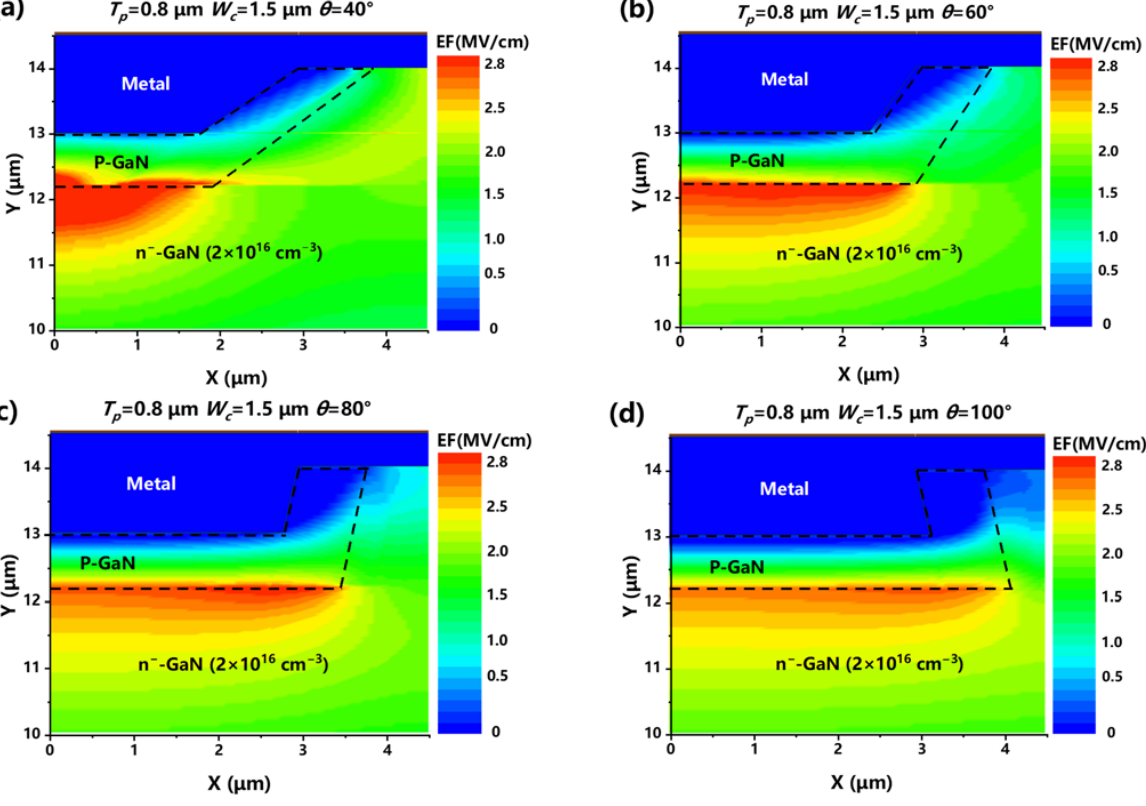
Figure 8. Local 2-D electric field distributions of TJBS diodes with a θ of ( a ) 40°; ( b ) 60°; ( c ) 80°; and ( d ) 100° with a p-doping concentration of 2 × 10 17 cm − 3 at a reverse bias of 1000 V.